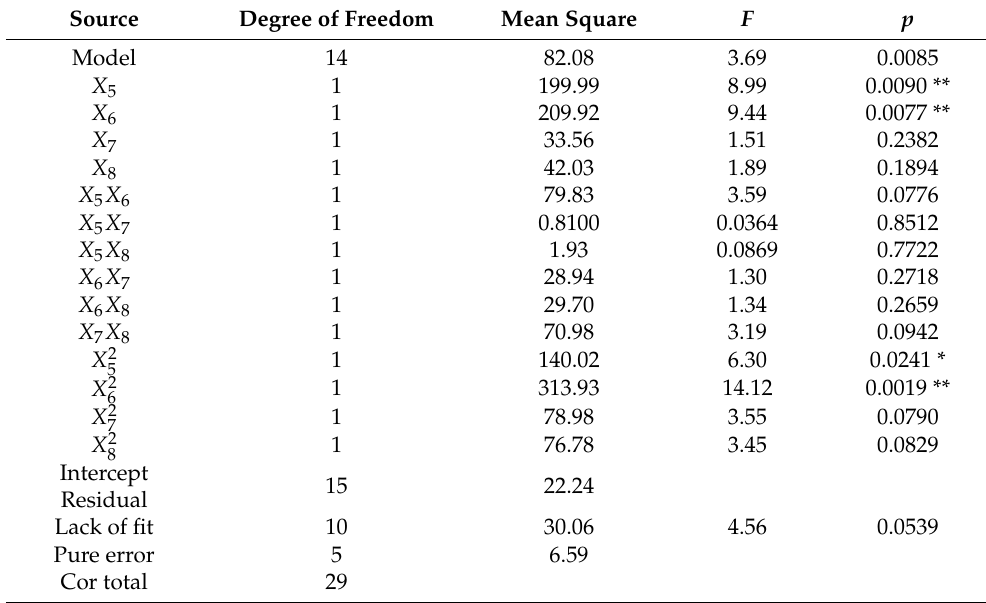
Table 8. Analysis of variance of quadratic regression model of internal flesh bending damage force response